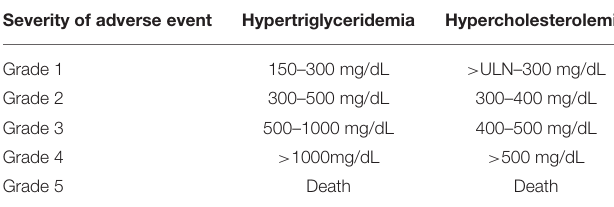
TABLE 2 | National Cancer Institute (NCI) grading of hypertriglyceridemia and hypercholesterolemia secondary to anti-neoplastic